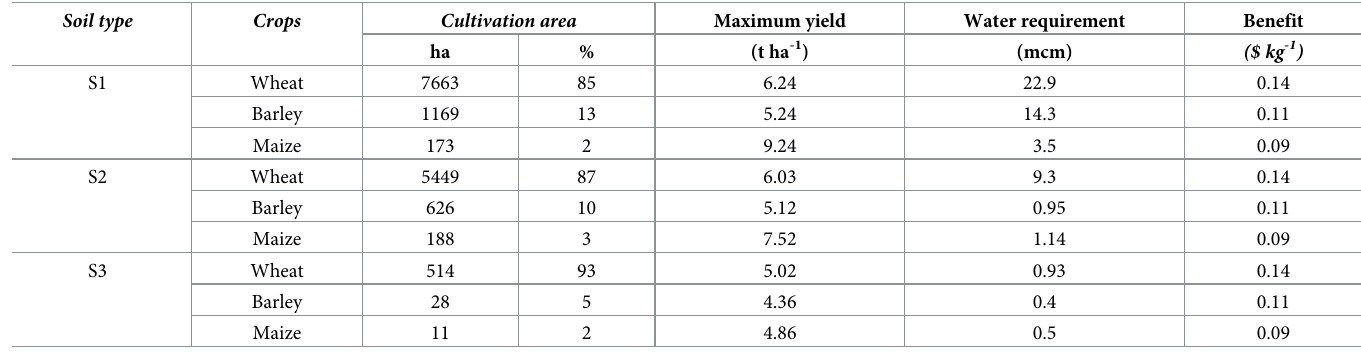
Table 6. Details of existing crops and economic information in the normal year. Soil